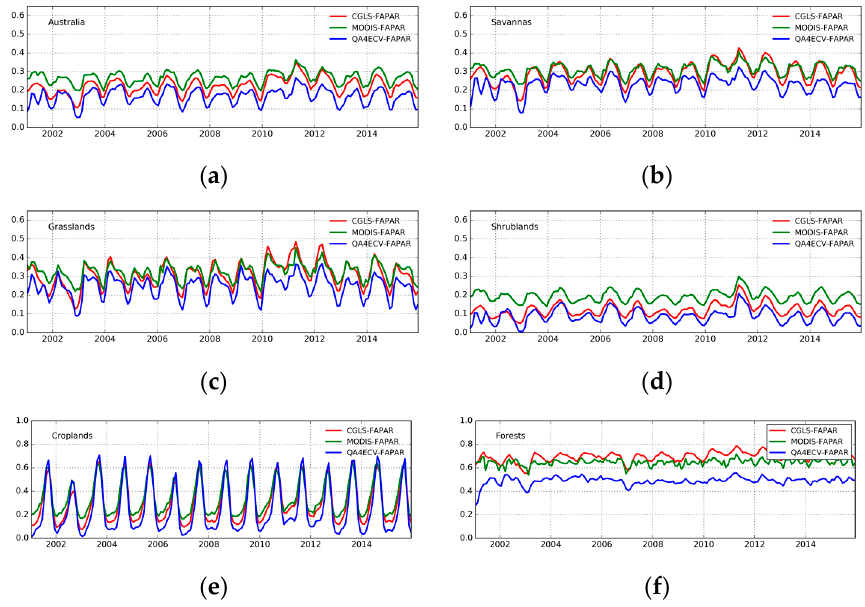
Figure 4. Time series of different FAPAR products over Australia and different land cover types: ( a ) Australia, ( b ) Savannas, ( c ) Grasslands, ( d ) Shrublands, ( e ) Croplands, ( f) Forests.